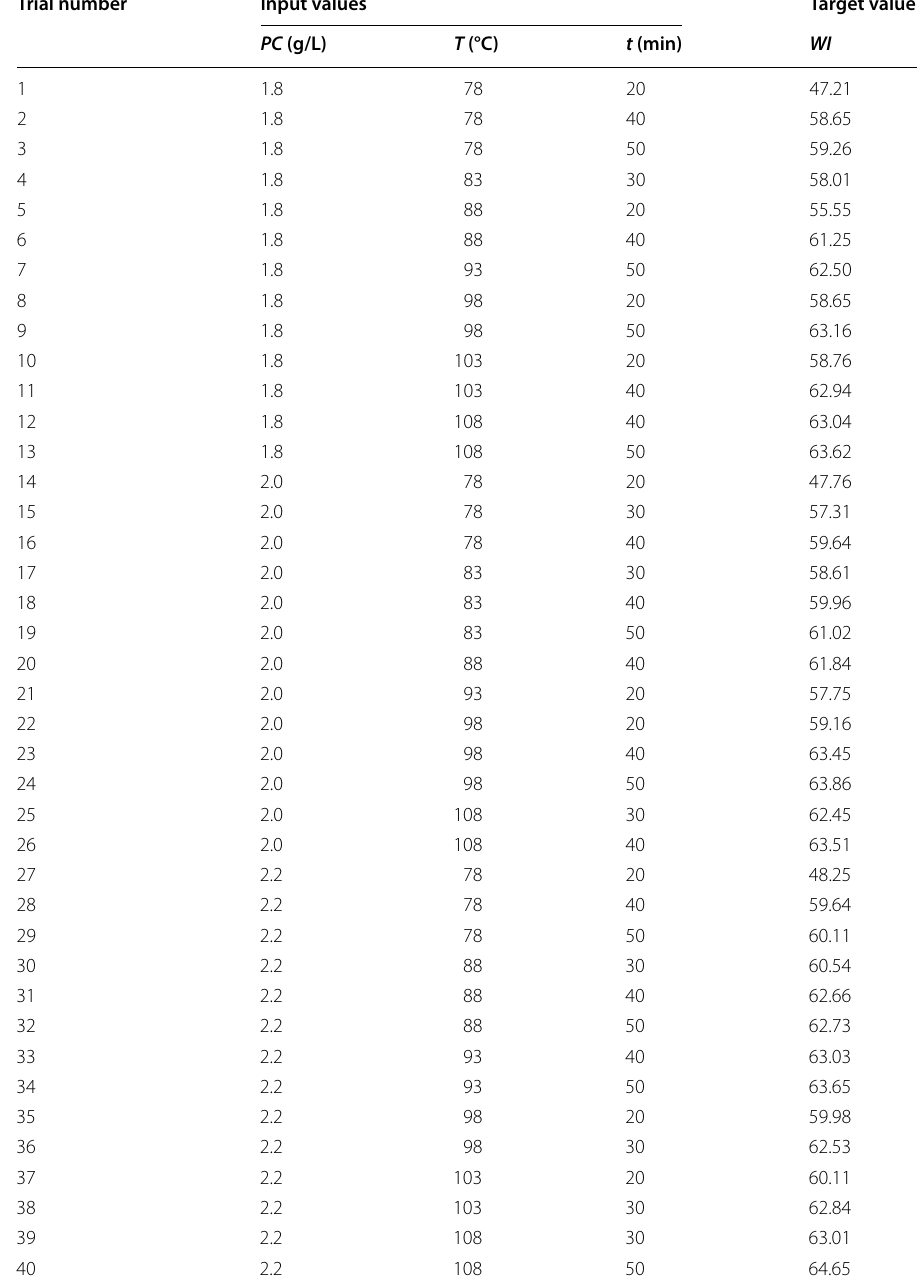
Table 1 Experimental results of whiteness